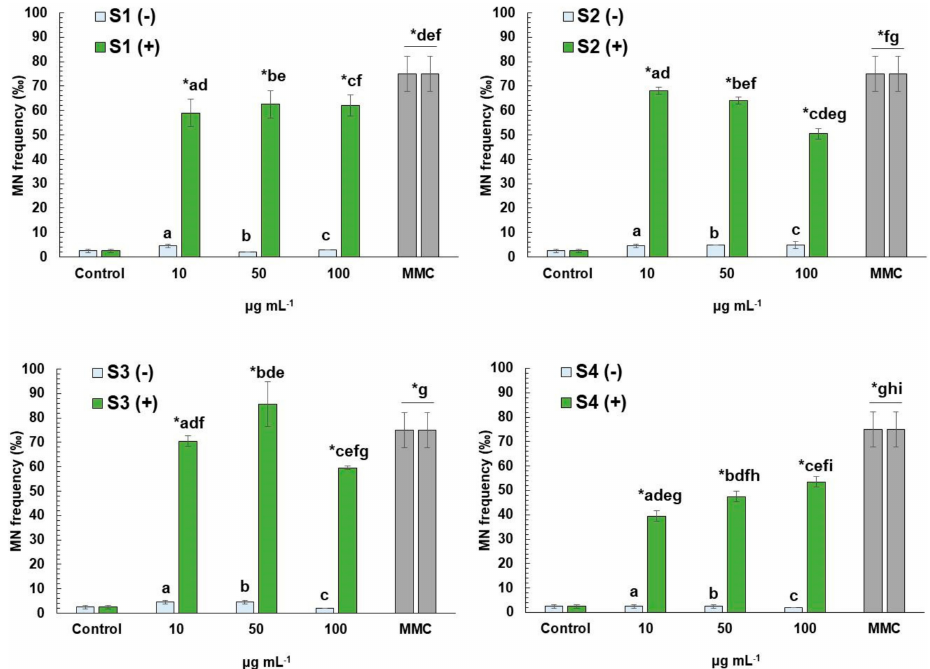
Figure 3. Micronuclei formation in human lymphocytes treated with MeOH (S1), EtOH (S2), water (S3) and EtOH-W (S4) extracts of E. arvense L. with (+) or without ( − ) the presence of mitomycin C (MMC, 0.5 µ g mL − 1 ). The results are mean ± SD from 3 independent experiments in each case. Values that share the same letter differ from each other. Asterisks (*) indicates significant difference from control in each case (Mann–Whitney u-test, p <